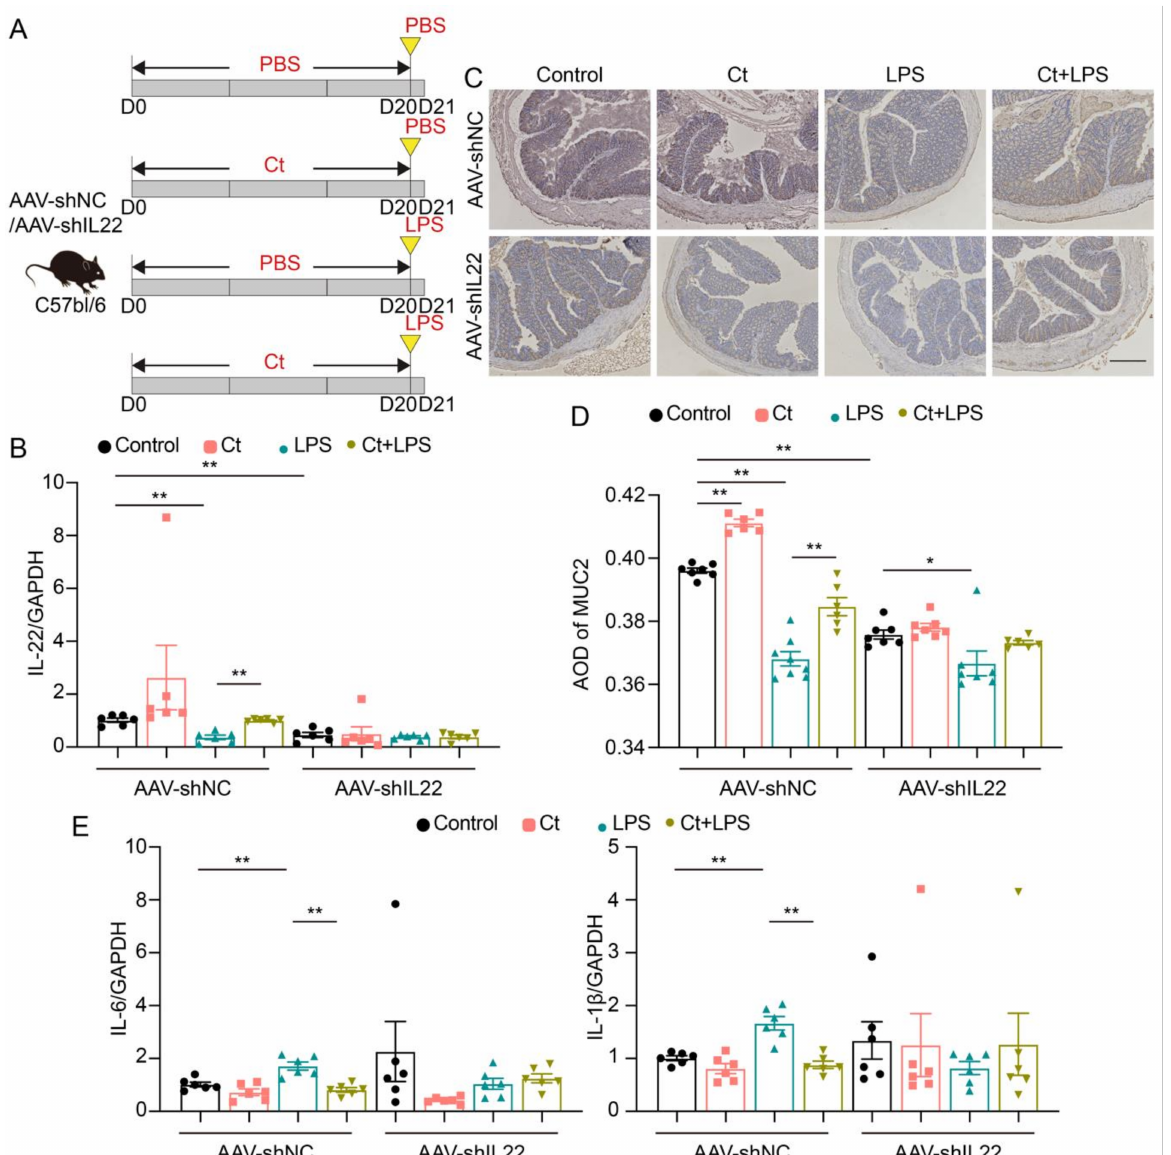
Figure 5. Ct protected against colonic barrier dysfunction and inflammation via IL-22 in mice. ( A ) Schematic for the feeding experiment. C57BL/6 mice were first intraperitoneal injection with AAV-shNC or AAV-shIL22 for 2 weeks, followed by treatments with PBS or 10 8 CFU/mL Ct by gavage every day for 20 days followed by intraperitoneal injection with PBS or LPS (10 mg/kg BW) at day 20 (D20), the samples were collected after 24 h (control, n = 19 in AAV-shNC, n = 17 in AAV-shIL22), Ct ( n = 14 in AAV-shNC, n = 12 in AAV-shIL22), LPS ( n = 20 in AAV-shNC, n = 18 in AAV-shIL22), and Ct + LPS ( n = 17 in AAV-shNC, n = 12 in AAV-shIL22); ( B ) relative mRNA expression of IL-22 ( n = 6); ( C ) immunohistochemistry images of colonic MUC2. Scale bars: 250 µ m; ( D ) average optical density (AOD) of MUC2; ( E ) relative mRNA expression of IL-6 and IL-1 β ( n = 6). Data presented as mean ± SEM. * p < 0.05, ** p < 0.01 by two-way unpaired t